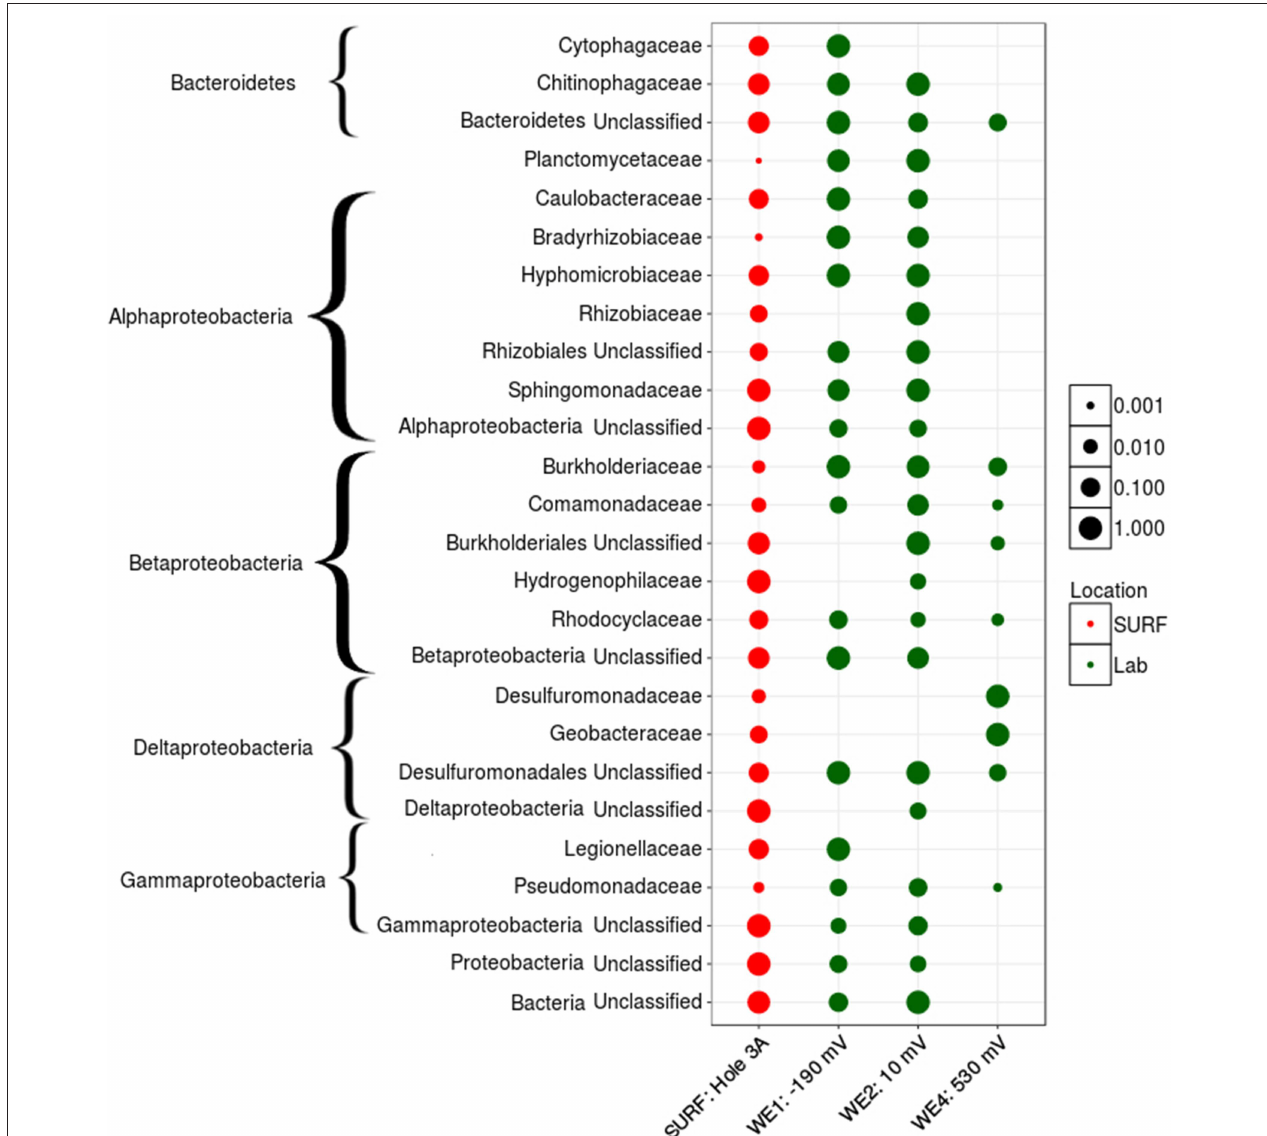
FIGURE 6 | Active family-level normalized relative abundance of bacterial community present in laboratory electrochemical enrichment. The size of the symbol represents the normalized relative abundance of that group across various habitat types (depicted by different